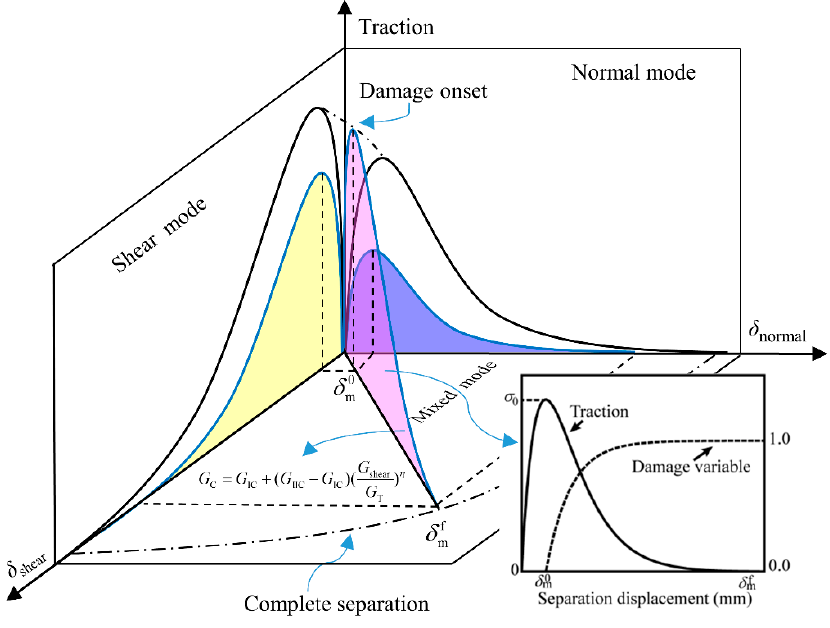
Figure 3. The mixed-mode ECZM.